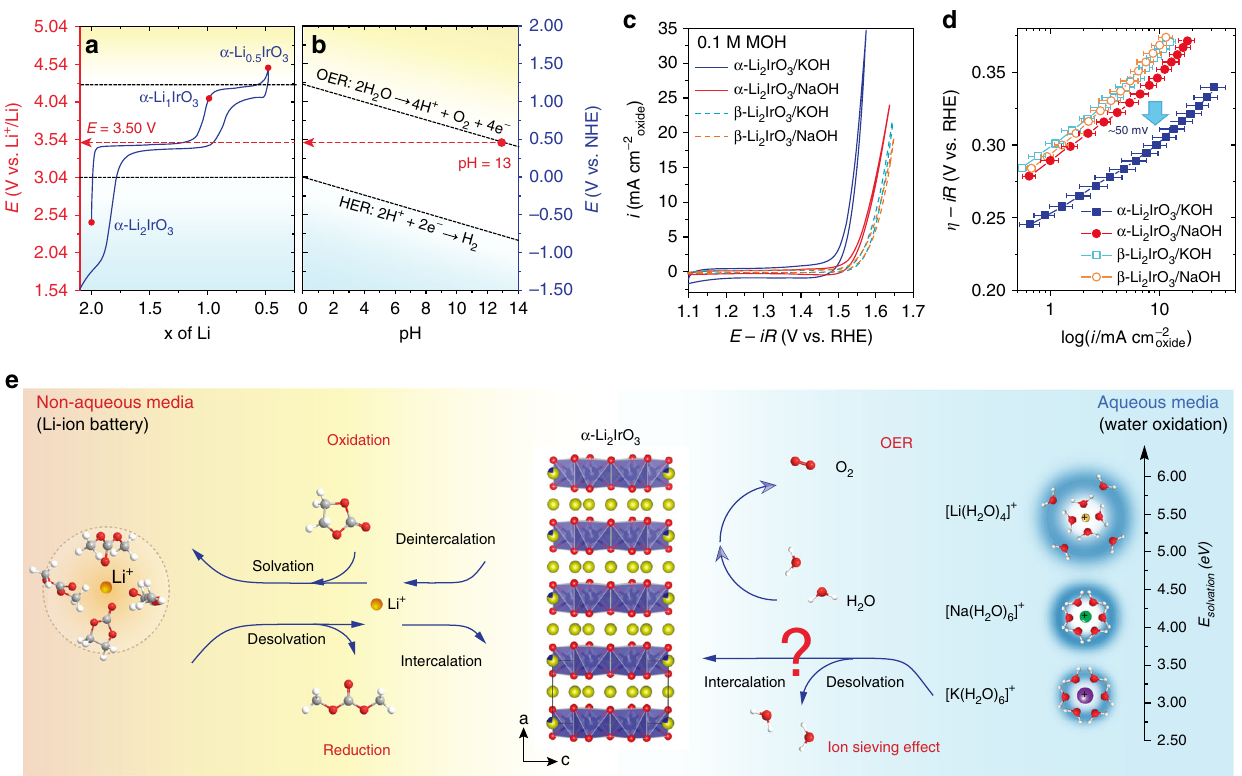
Fig. 2 Electrochemical activity. a Cycling curve of α -Li 2 IrO 3 as Li-ion battery electrode in organic solvent compared to b the Pourbaix diagram for water oxidation and reduction redox potentials as a function of pH. c CV curves of the layered α -Li 2 IrO 3 phase compared to the 3D β -Li 2 IrO 3 polymorph in 0.1 M KOH and NaOH aqueous solutions and d comparison of the corresponding Tafel plots. e Links between non-aqueous media (battery system) and aqueous media (water system) when using α -Li 2 IrO 3 and β -Li 2 IrO 3 as cathode materials in Li-ion battery and catalysts in aqueous for water splitting. The OER process in aqueous system may involve the intercalation and deintercalation of alkaline cations (such as Li + , Na + , and K + ) in/out of the layered structure, which may be strongly affected by the desolvation energy of water molecules from solvated alkaline